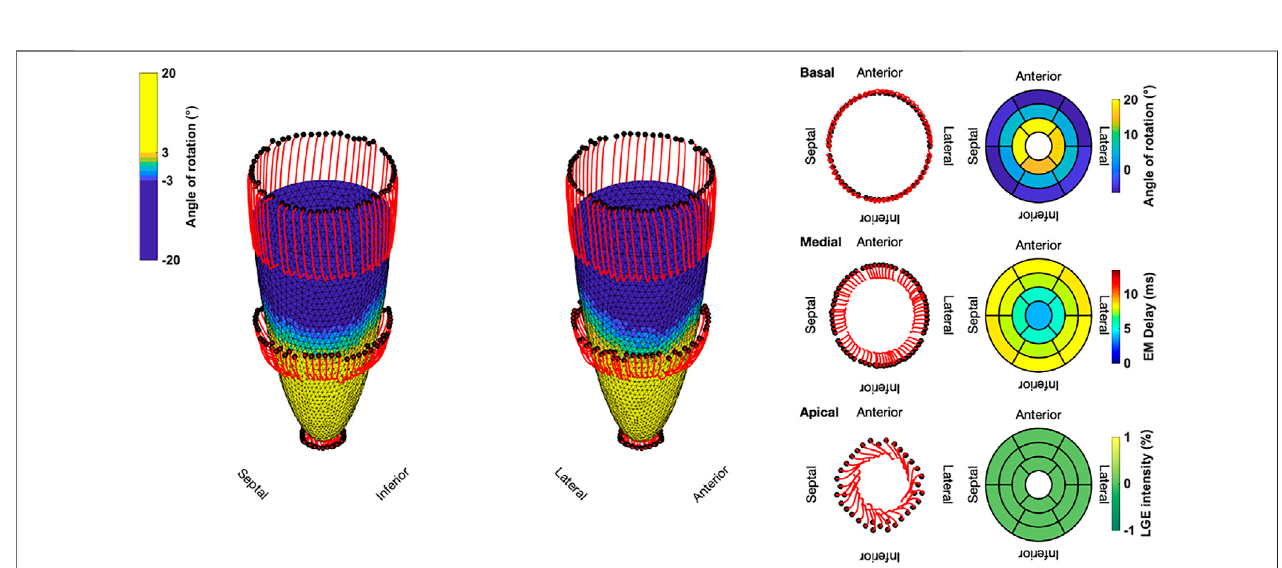
FIGURE 4 | Three-dimensional trajectories (red lines) of selected points on the endocardium in the basal, medial, and apical sectors for the Control case. The endocardial surface during end-systole is shown with rotational values depicted on the faces of the mesh. Solid black dots represent the initial positions. Bullseye plots show the segmential mean values of the angle of rotation, electromechanical (EM) delay, and LGE